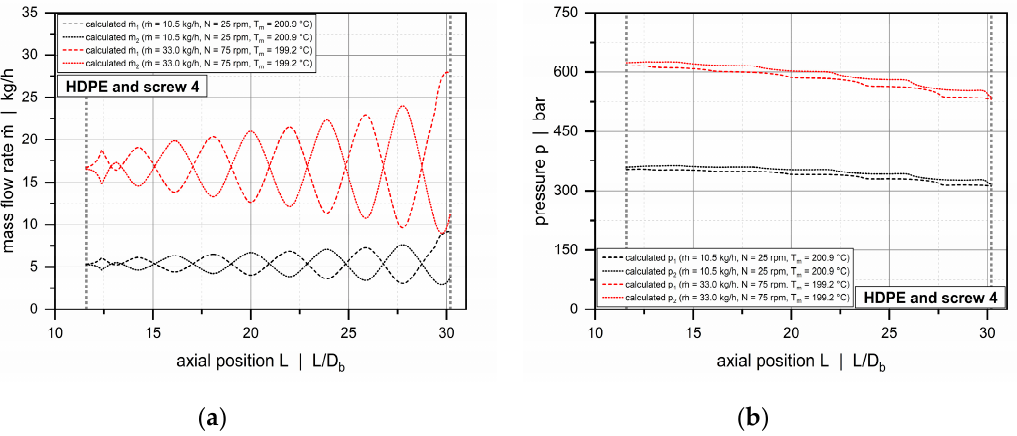
Figure 18. Distribution of mass-flow rates ( a ) and pressures ( b ) in subchannels 1 and 2 for barrel 2 (helically grooved extruder) and screw 4. The dashed and dotted lines represent the solutions for subchannels 1 and 2, respectively.